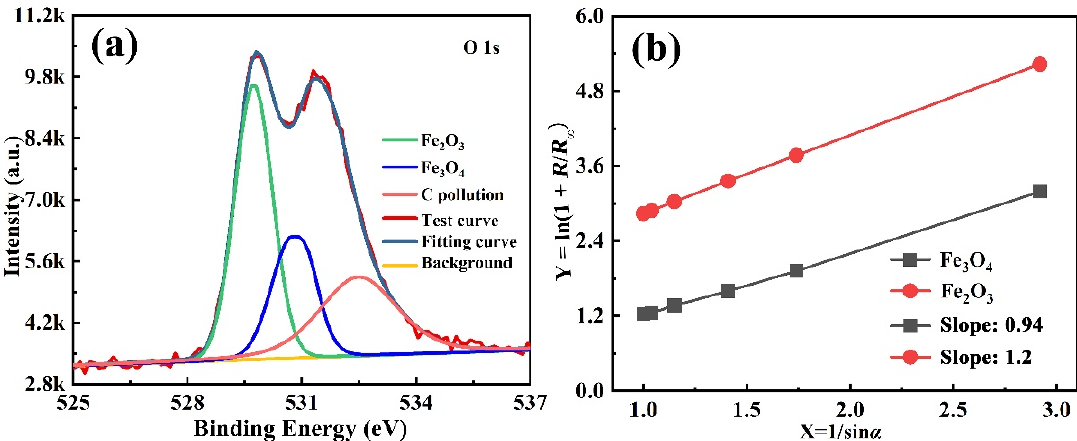
Figure 9. ( a ) ARXPS spectra of O 1s photoemission and the fitting results, ( b ) the results of ln(1 + R / R ∞ ) against 1/sin α for the iron oxides in NiFe thin film. Table 3. Relative peak intensities ( I s and I o ) and the I o / I s ratios for both iron oxides in the NiFe (100 nm) thin film. α ( ◦